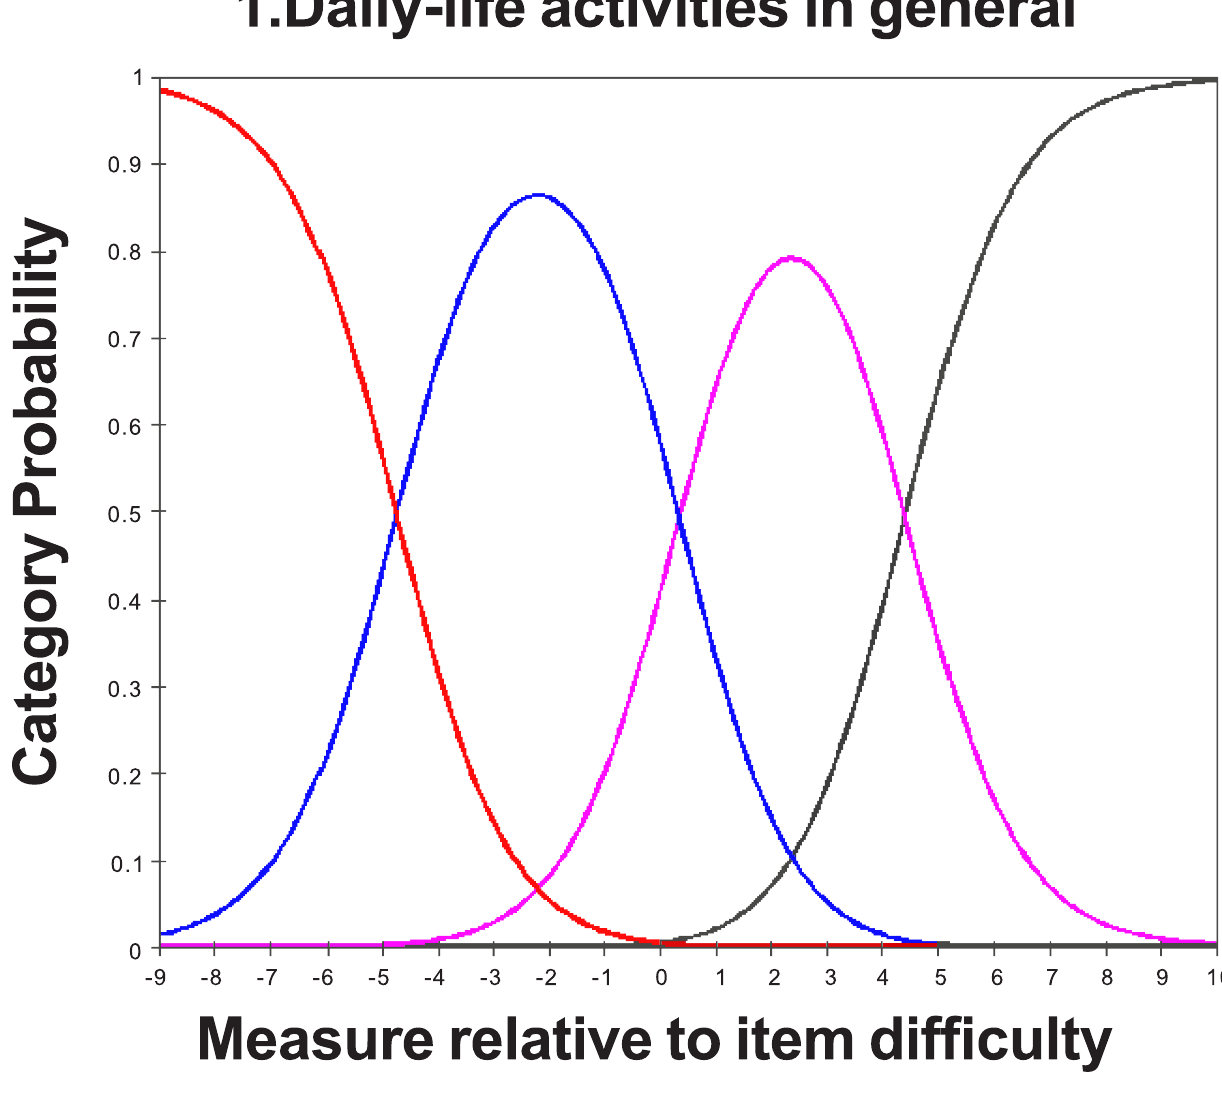
Figure 1. Category probability curves for the global ‘‘difficulties in your daily life’’ item, which illustrates ordered threshold. doi:10.1371/journal.pone.0103860.g001 Table 2. Item infit statistics and item difficulty rating